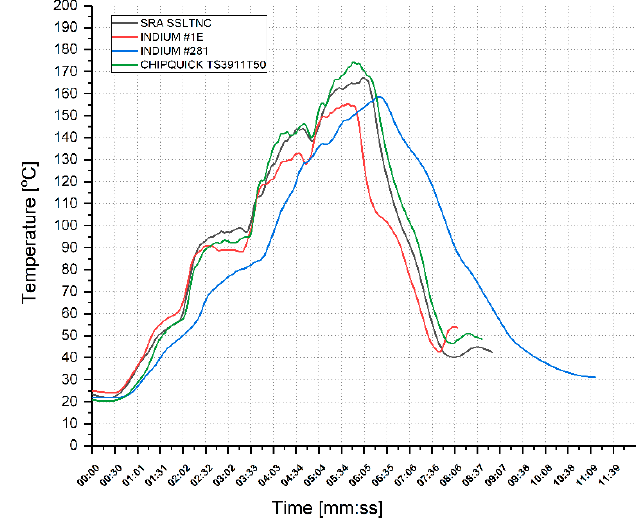
Figure 10. Temperature profiles used for soldering.